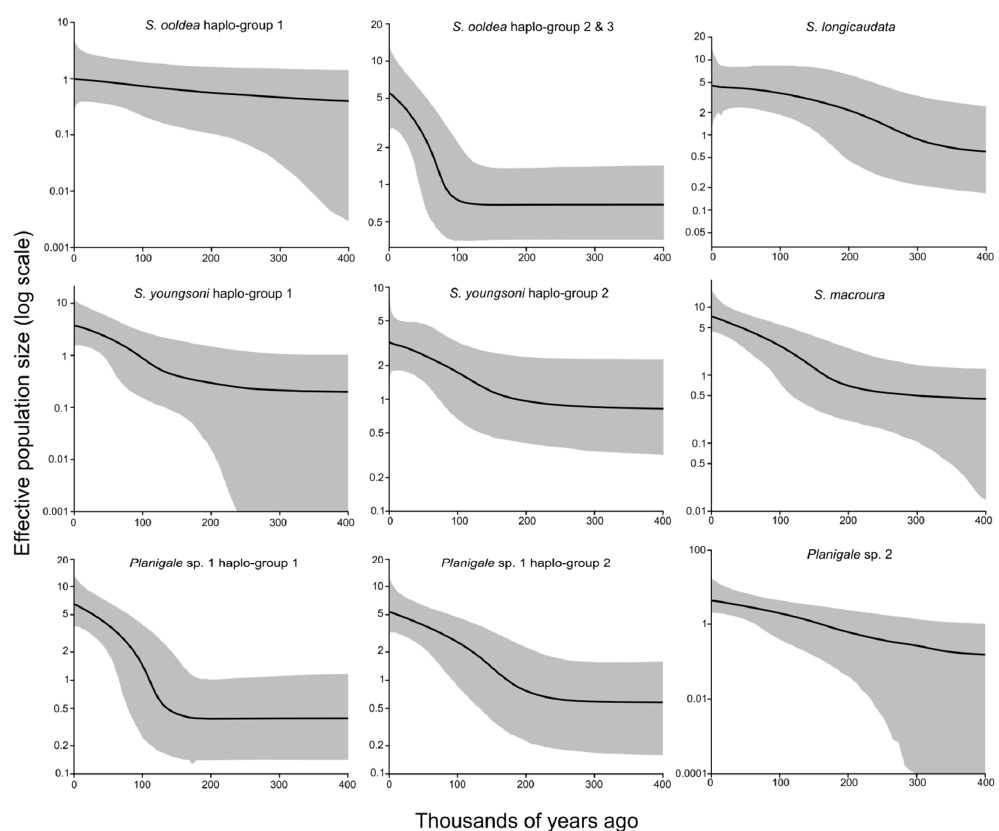
Figure 4. Extended Bayesian skyline plots showing population size changes over time using the combined mitochondrial ( CR + cytb ) and nuclear DNA sequence data of each species and haplo group in this study. The median posterior estimates of demographic change over the past 400,000 years are graphed with the gray area indicating the 95% central posterior density/credible